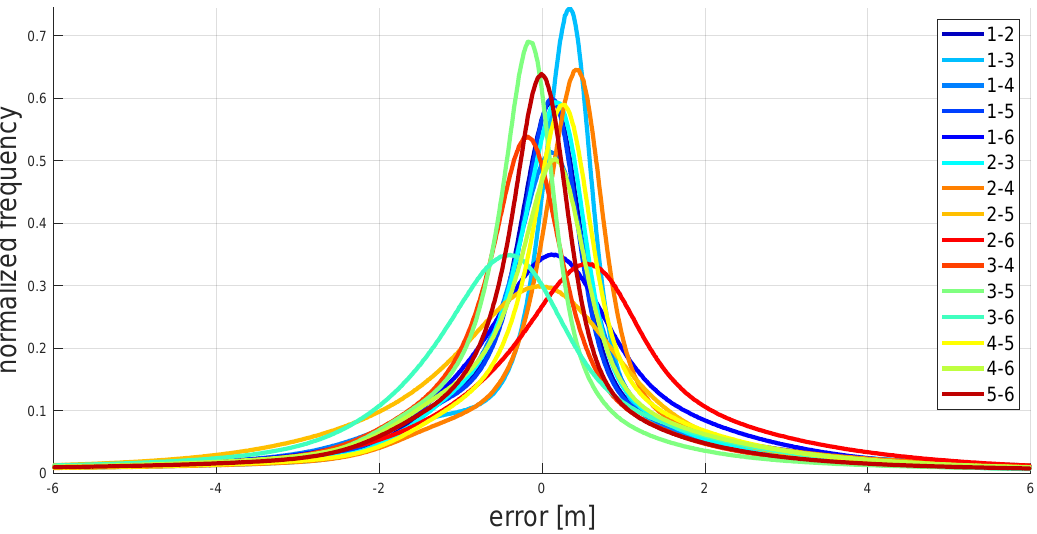
Figure 22. Distribution of differences from LiDAR and Pléiades DSMs for all 15 stereo pairs of the Ljubljana test site. The error range of − 6 m to + 6 m is